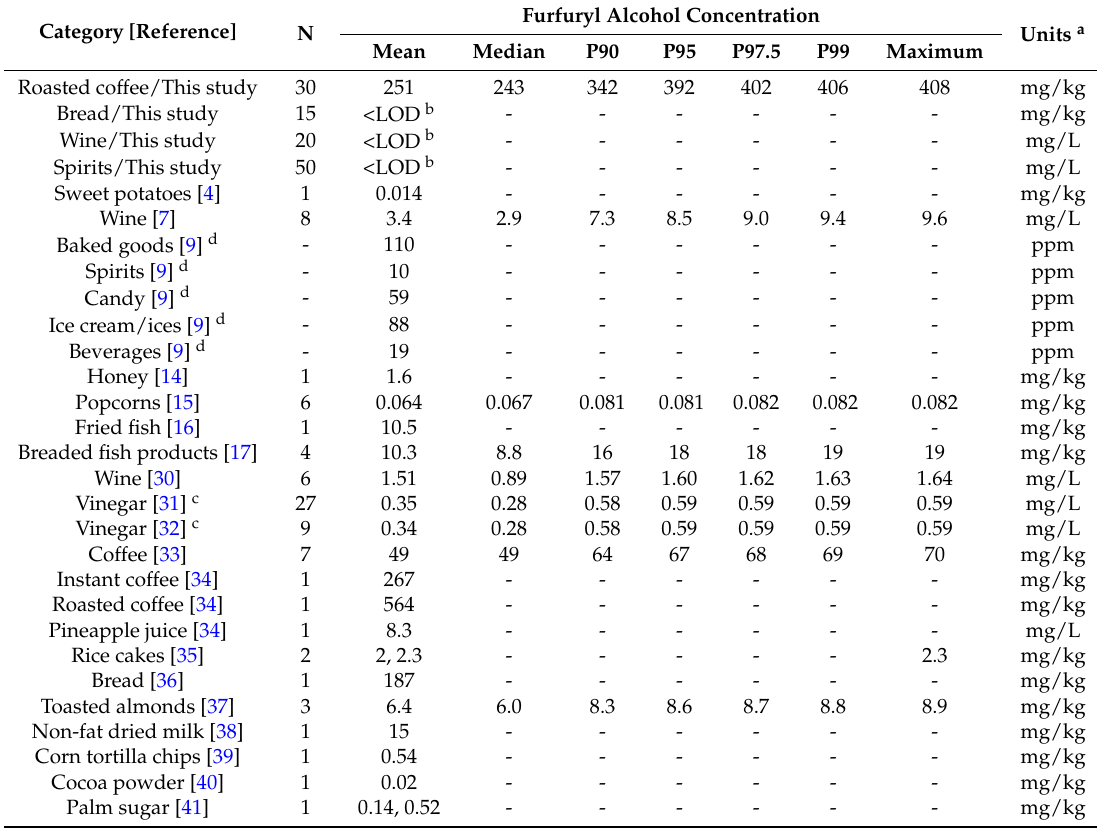
Table 1. Furfuryl alcohol content in various foods and